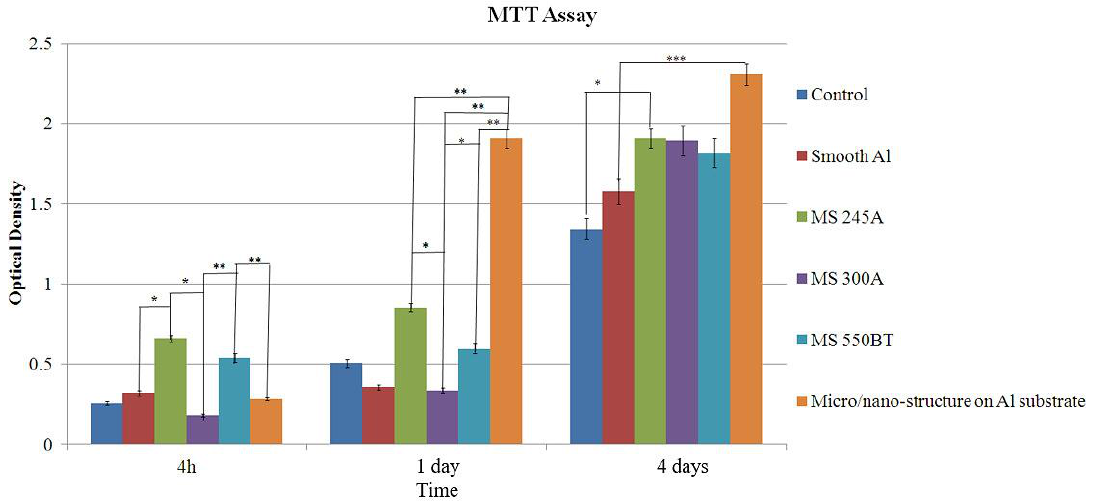
Table 1. Contact angles and surface roughnesses for different structured templates by Tukey-test. Group